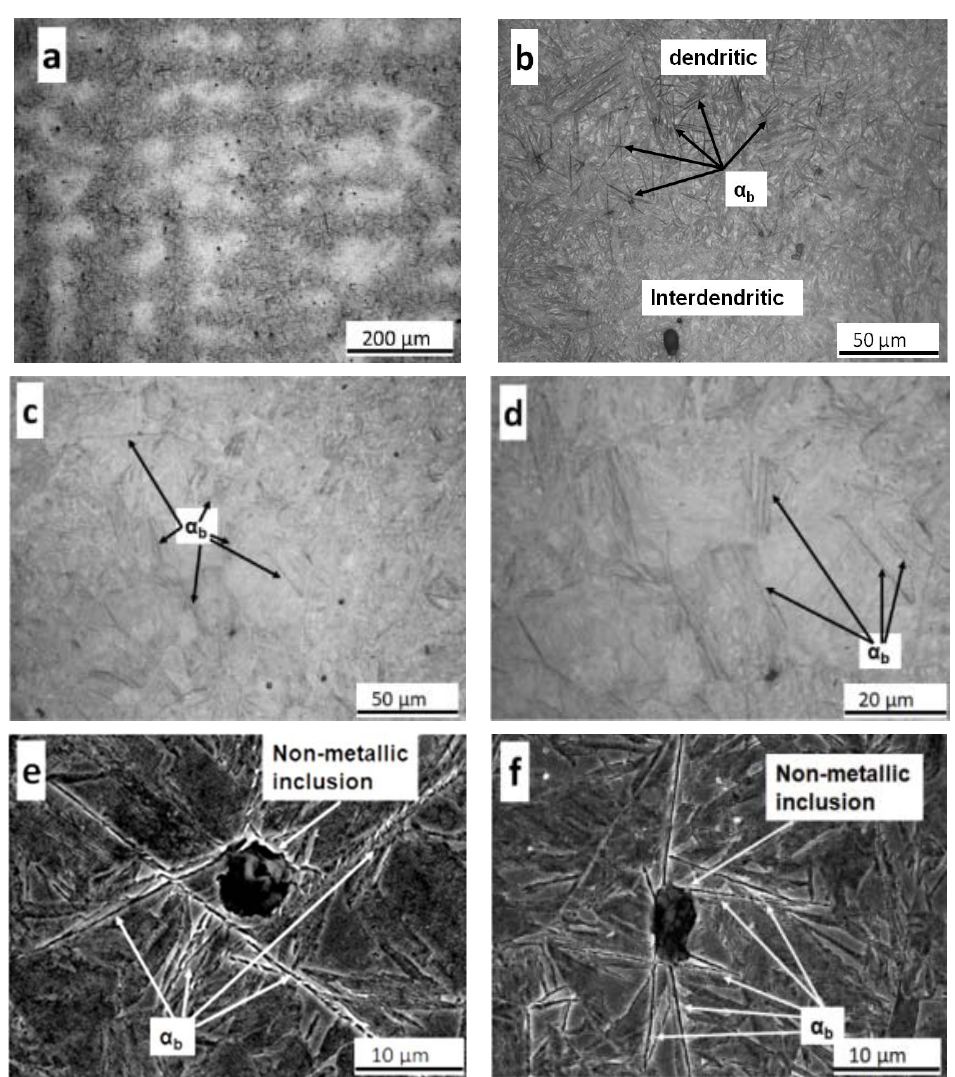
Figure 13b: dual dendritic/interdendritic zones and, in Figure 13c,d: only dendritic zones. Finally, Figure 13e,f are high magnification FEG ‐ SEM images where the nucleation of bainitic ferrite on inclusions was observed.